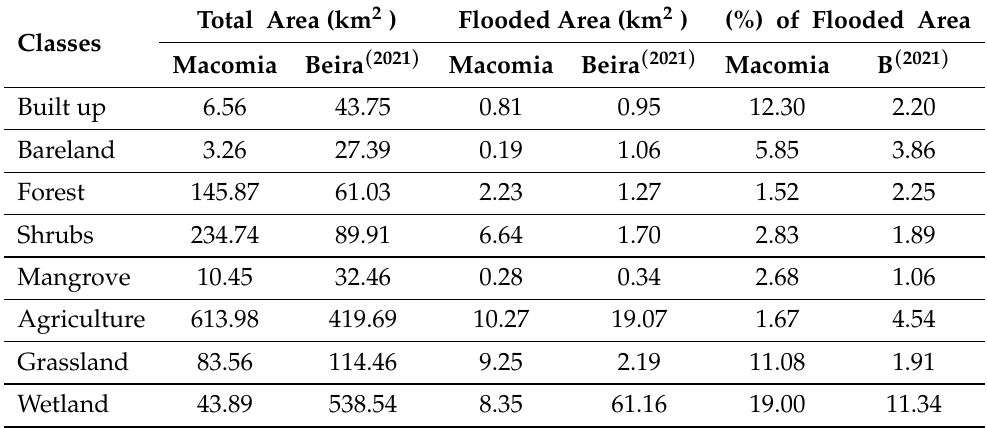
Table 8. Flooded areas in km 2 and the percentages for each LC that was classified in Macomia and Beira. The results from 28 April 2019, in Macomia and 25 January 2021, in